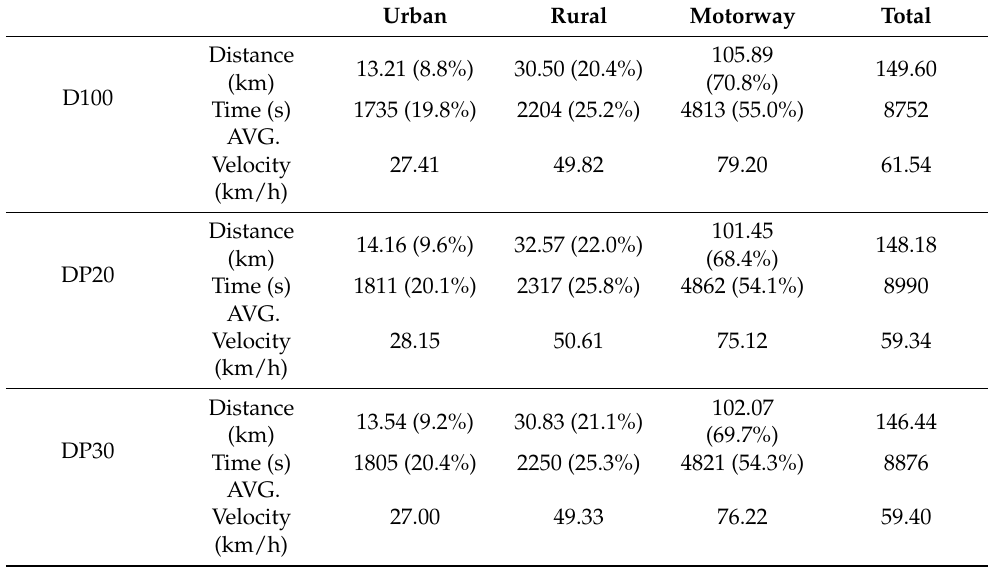
Figure 3. Second-by-second speed and altitude records of the vehicle under different fuel conditions. Table 4. Actual driving distance and time of experiments under conditions of different